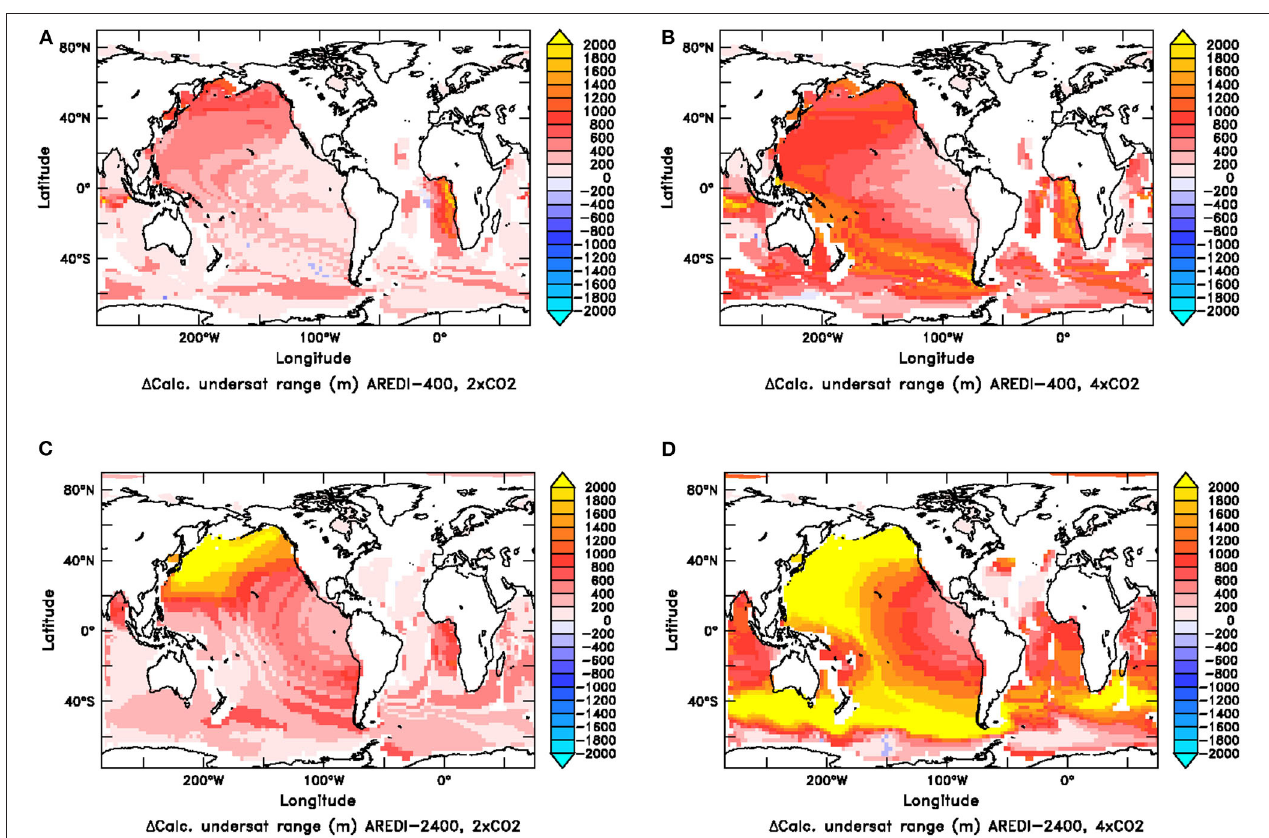
FIGURE 12 | Change in the vertical extent of the water column over which calcite undersaturation is found for the 2xCO 2 (A,C) and 4xCO 2 (B,D) simulations for the AREDI-400 simulations (top row) and AREDI-2400 simulations (bottom row).